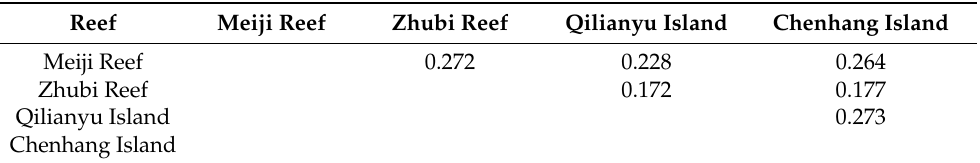
Table 6. Jaccard similarity indices ( J s ) of fish assemblages among Meiji Reef, Zhubi Reef, Qilianyu Island and Chenhang